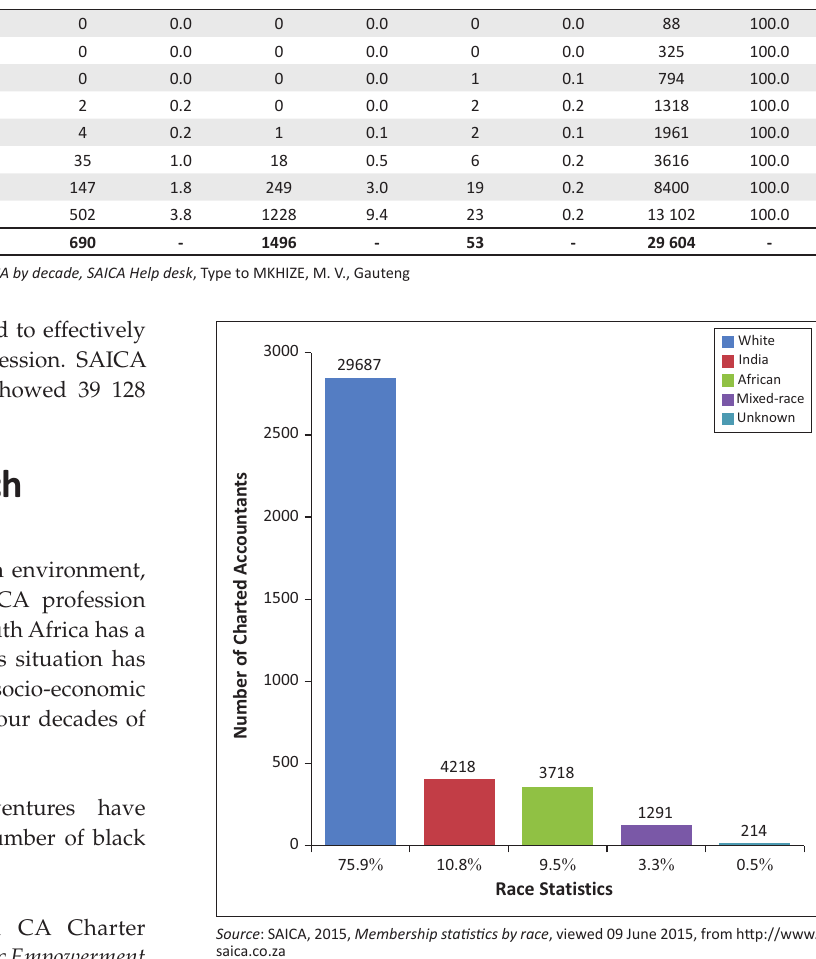
TABLE 1: New admissions to the South African Institute of Chartered Accountants by decade. Decade White Asian